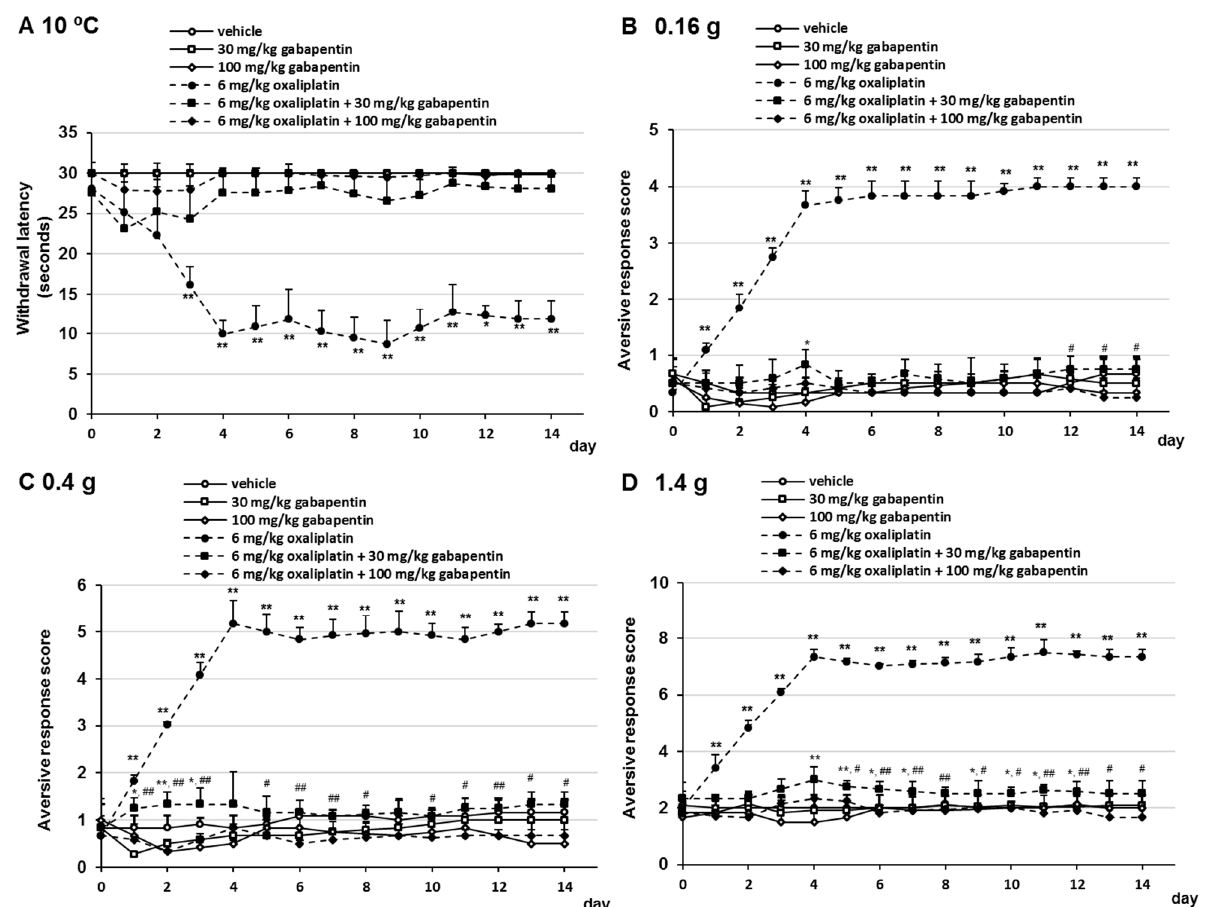
Figure 1. Inhibitory effect of gabapentin on oxaliplatin-induced cold allodynia in mice. Oxaliplatin (6 mg/kg/i.v.) was administered on days 0 and 7, and gabapentin (30 or 100 mg/kg, p.o.) was administered daily from days 0 to 14. ( A ) Withdrawal latencies, presented as means ± standard deviations (S.D.), represent the time taken by mice to withdraw their hind paws following cold stimulation (10 °C) ( n = 7 per group). * p < 0.05, ** p < 0.01 vs. vehicles (Shapiro–Wilk test and Kruskal–Wallis test followed by the Scheffe test). ( B – D ) The number of paw lifts elicited by five mechanical stimulations using von Frey filaments corresponding to ( B ) innocuous (0.16 g), ( C ) intermediate (0.4 g), and ( D ) noxious (1.4 g) bending forces. The aversive response score was calculated based on two paw lifts ( n = 7 per group). * p < 0.05, ** p < 0.01 vs. vehicles, # p < 0.05, ## p < 0.01 vs. 6 mg/kg oxaliplatin + 30 mg/kg gabapentin (Shapiro–Wilk test and one-way analysis of variance (ANOVA) with the Tukey test).